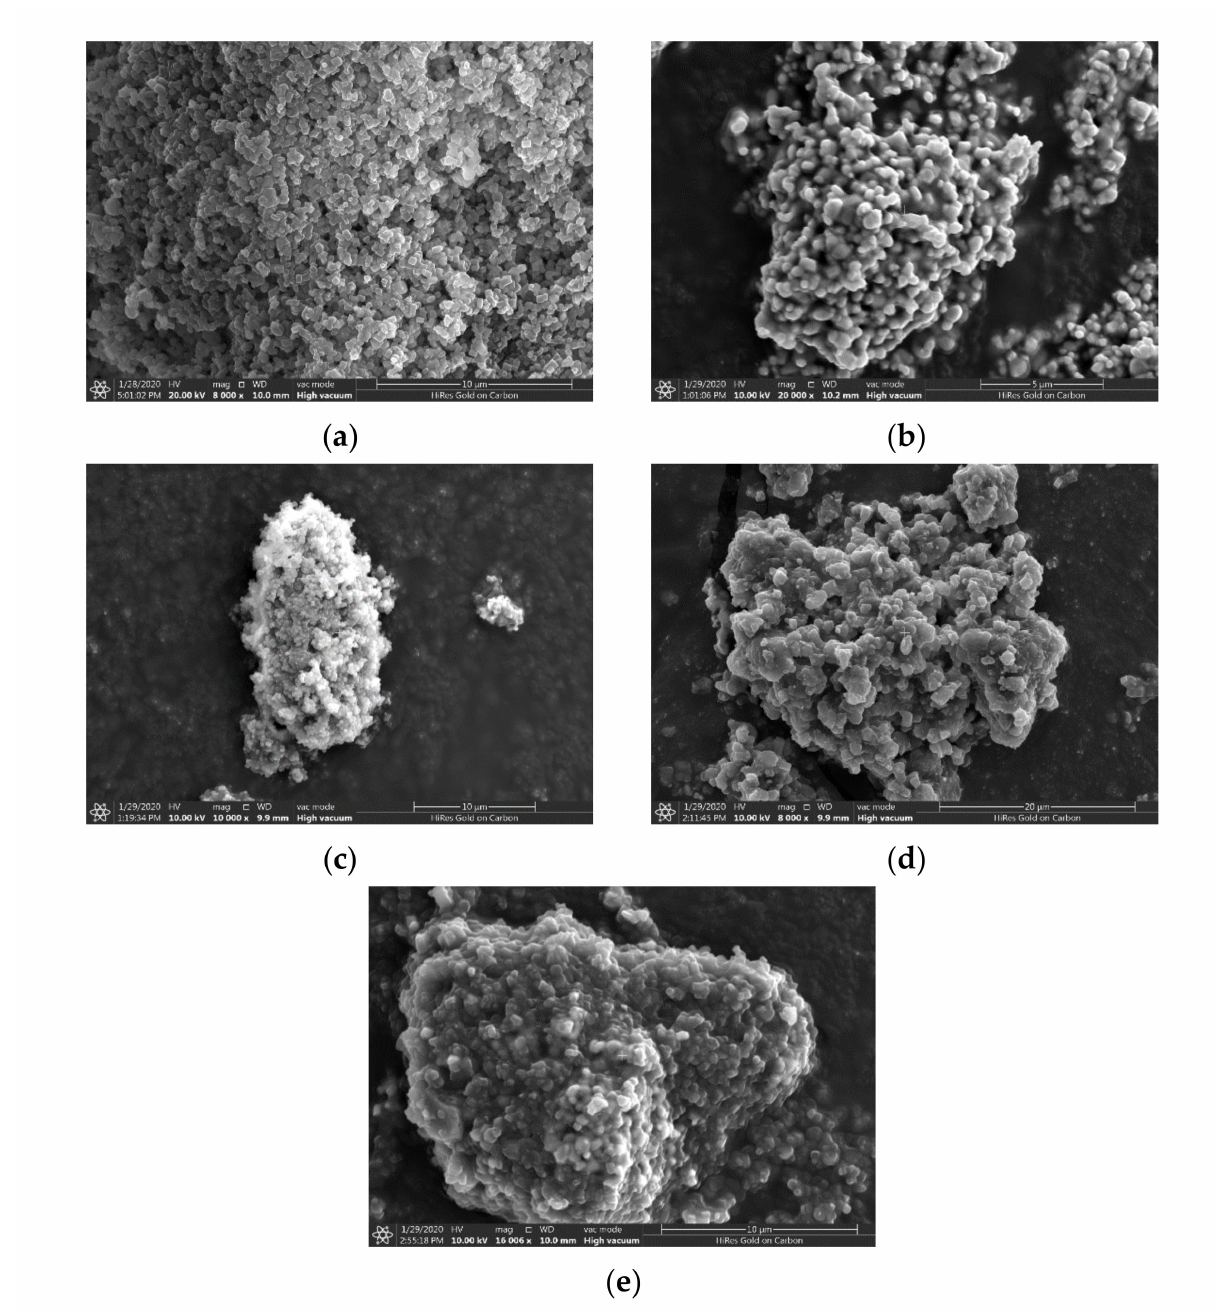
Figure 6. SEM images of ( a ) NH 2 -MIL-125(Ti), ( b ) FeNbO 4 , ( c ) FeNbO 4 (25%) /NH 2 -MIL-125(Ti) (75%) , ( d ) FeNbO 4 (50%) /NH 2 - MIL-125(Ti) (50%) and ( e ) FeNbO 4 (75%) /NH 2 -MIL-125(Ti) (25%) . EDX analyses confirmed the elemental composition of pure NH 2 -MIL-125(Ti), FeNbO 4 , and composite photocatalysts with no extra peaks observed for any impurities present in the sample (Table 2). Elemental mapping shows the distribution of C, N, O, Ti, Fe, and Nb in the samples (Figure